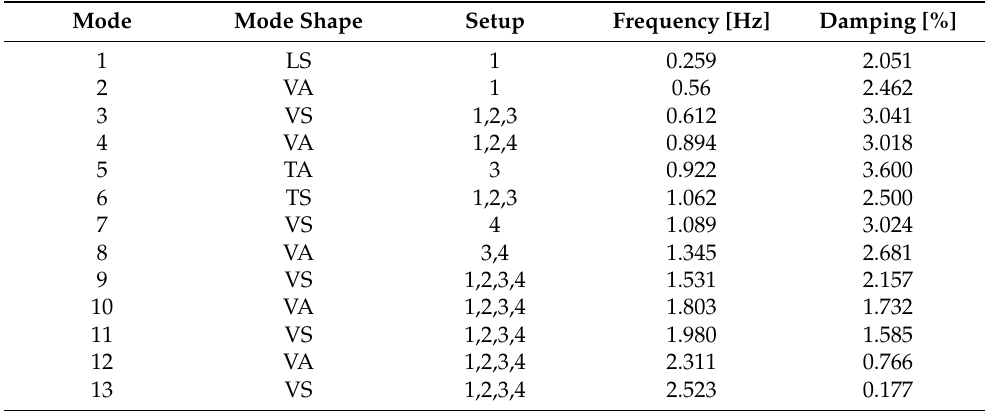
Table 2. Average identified modal parameters using the SSI technique.